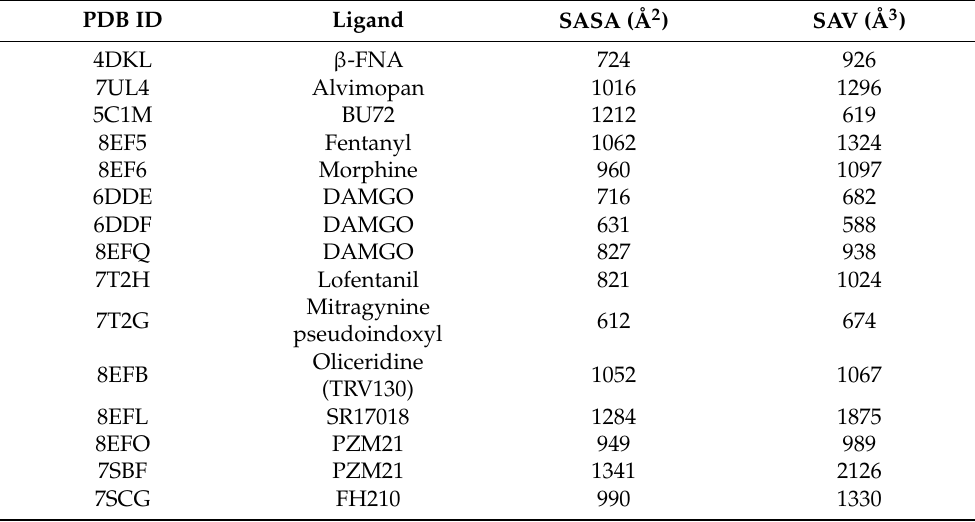
Figure 5. The common residues found within 4 Å for the antagonist (yellow), agonist (red), and partial agonist (light blue) are shown in licorice. The common residues found within 4 Å between the antagonist and agonist are colored orange, between the agonist and partial agonist are colored purple, and between the partial agonist and antagonist are colored green. The molecular image in this figure was generated with ChimeraX 1.4. [44,45]. Table 5. Binding site solvent accessible surface area (SASA) and solvent accessible volume